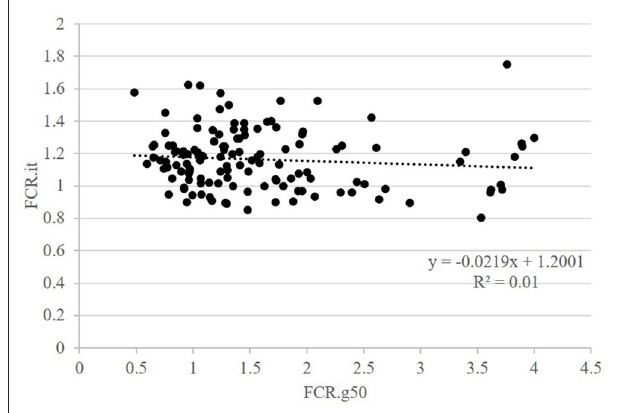
FIGURE 2 | Relations between FCR when fish were reared in groups and fed with either an optimal feed ration (g100) or a 50% restricted ration (g50). Each point is representing data for one fish.